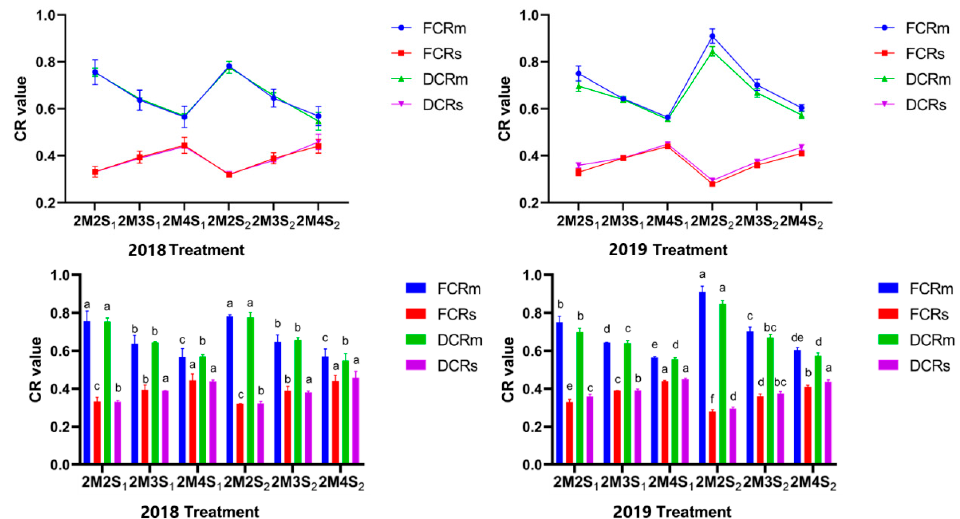
Figure 2. Competition ratios of maize–soybean intercropping. FCRm , competition ratio of maize based on fresh matter yield; FCRs , competition ratio of soybean based on fresh matter yield; DCRm , competition ratio of maize based on dry matter yield; DCRs , competition ratio of soybean based on dry matter yield. Different lowercase letters above the column indicate significant differences ( p < 0.05).